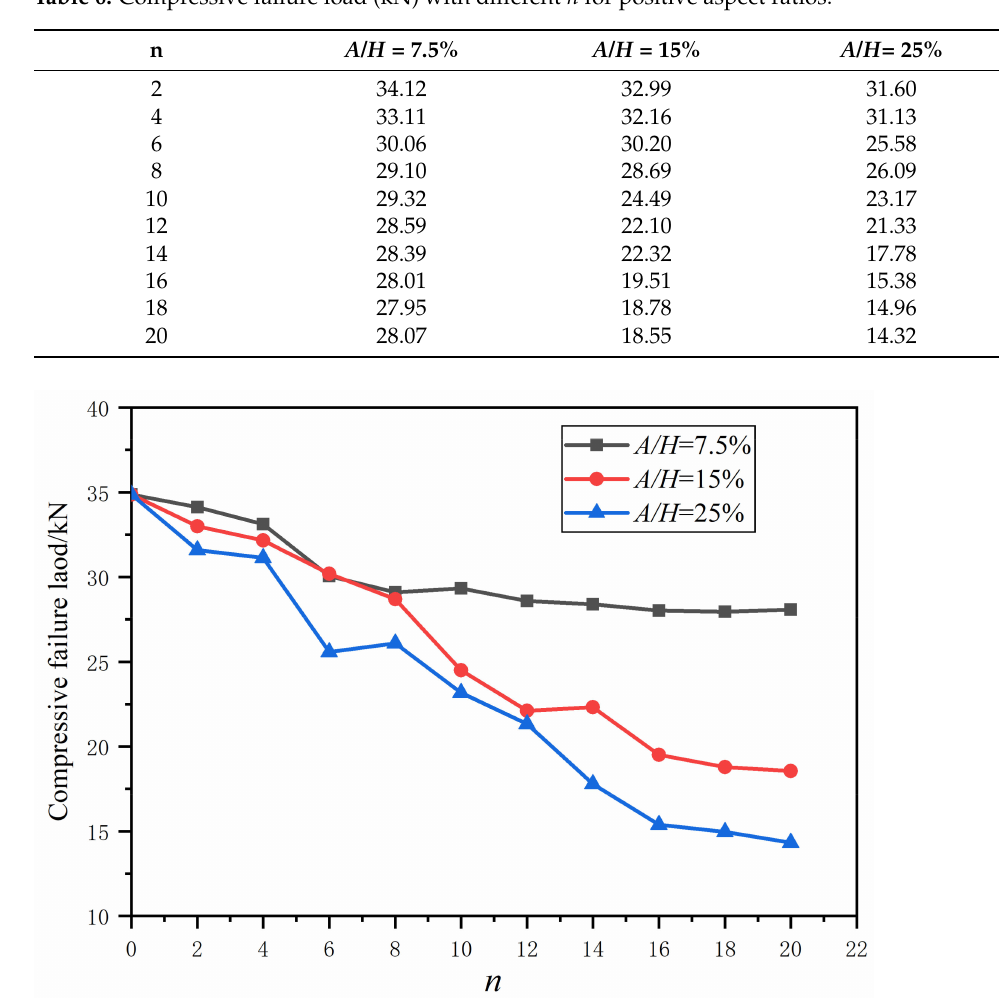
Figure 15. Compressive failure loads vs.